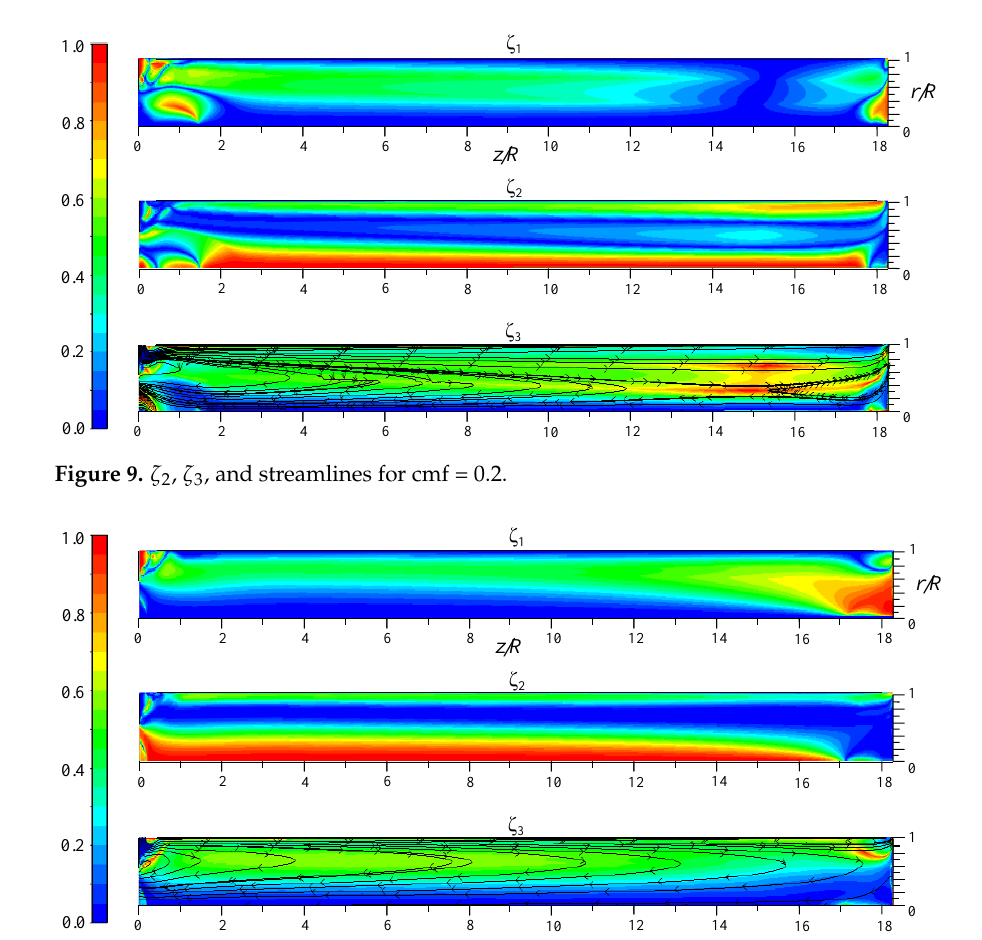
Figure 10. ζ 2 , ζ 3 , and streamlines for cmf = 0.8.